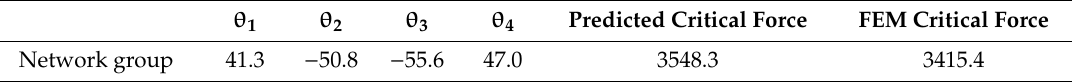
Table 8. The values of the optimum angle configurations, determined for group neural network as well as the values of the predicted critical forces and obtained using FEM. θ 1